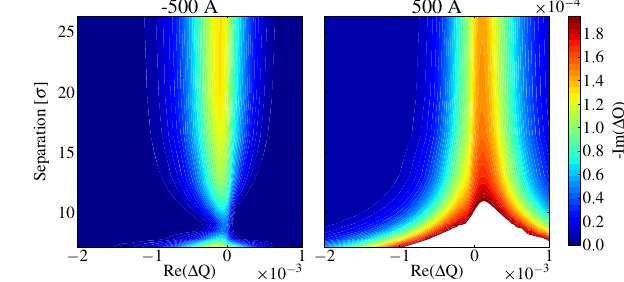
FIG. 6. Stability diagrams with both polarity of the octupoles for different long range contributions, corresponding to the configuration before the squeeze (None), after the squeeze, considering the most common bunch, i.e., largest long range contribution, and a PACMAN bunch with least long range contribution. The machine and beam parameters are those of 2012, neglecting the contribution of IP2 and 8.